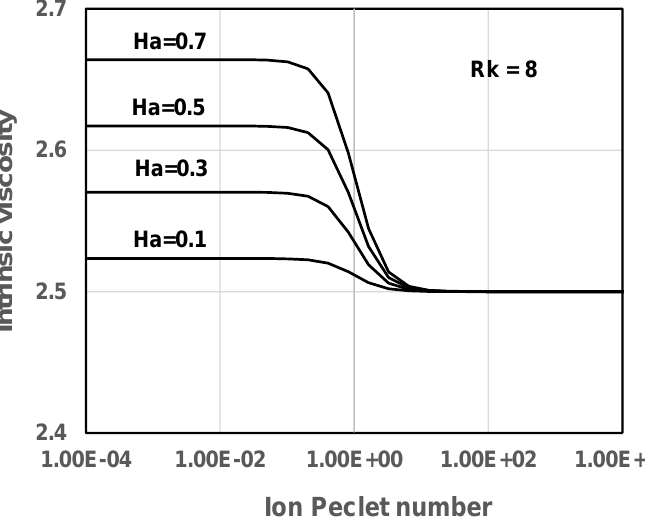
Figure 6. Variation of [ η ] with Pe for suspensions of charged particles at different values of Hartmann number (Rk fixed at 8).